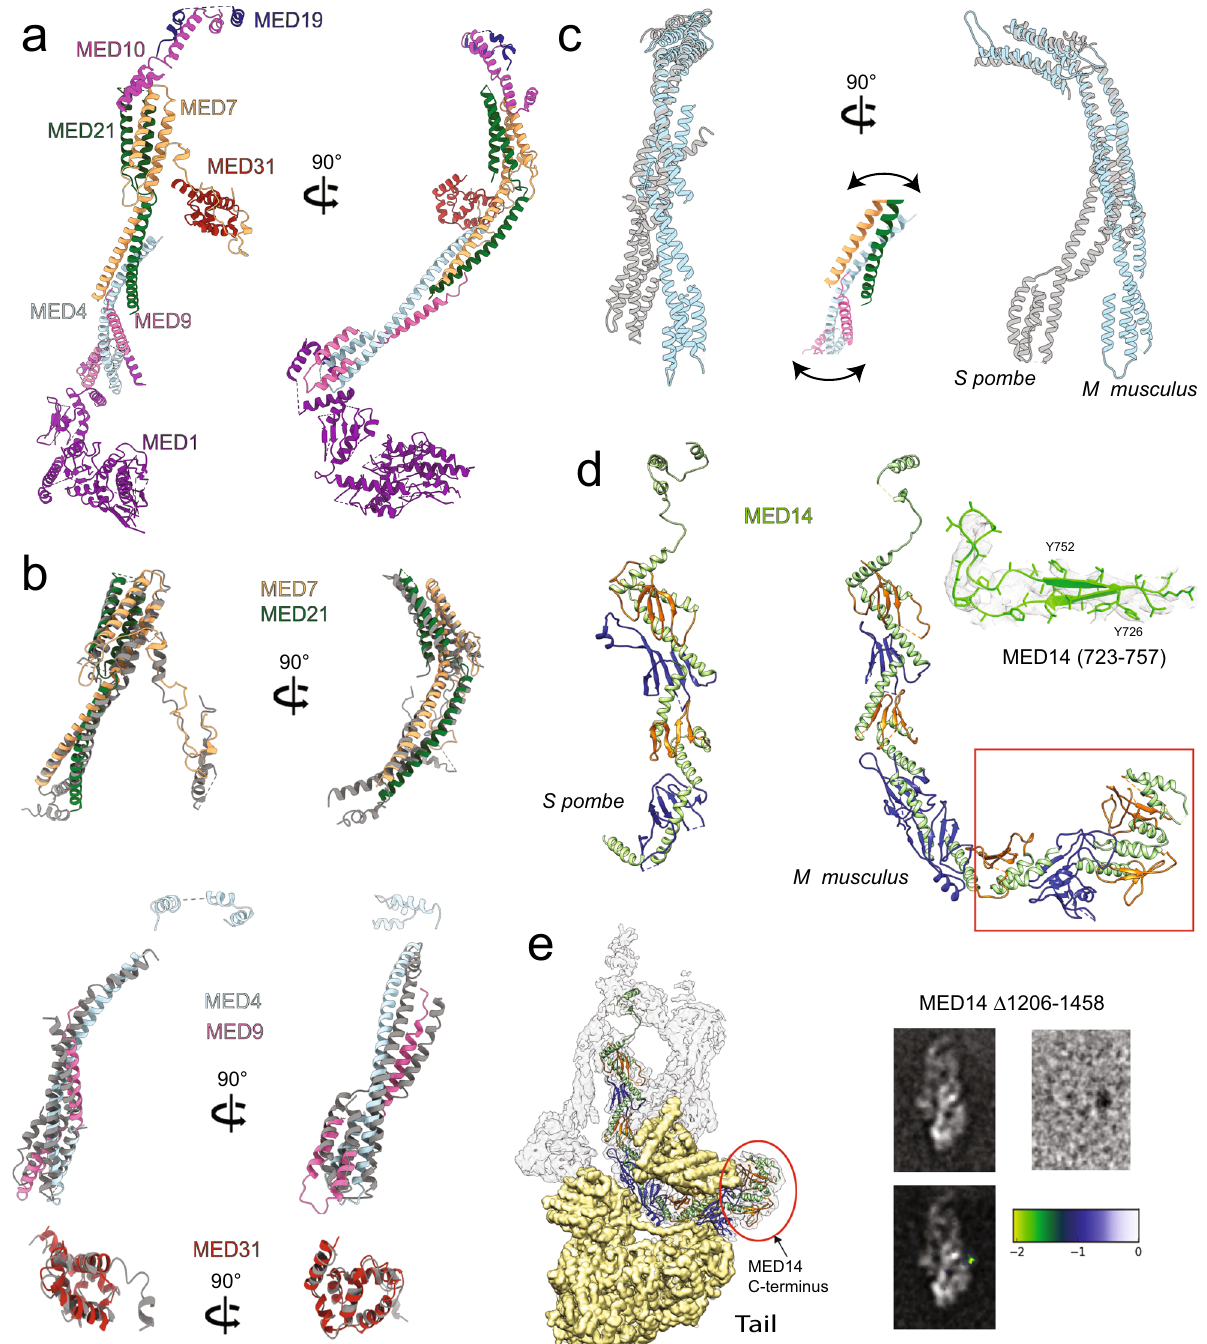
Fig. 3 Structure of the mammalian Middle module and MED14. a Overall mammalian Middle module structure, including a partial MED1 model. b The structure of MED7 – MED21 (top), MED4 – MED9 (middle) and MED31 (bottom) are mostly conserved between yeast and mammalian Mediators (yeast subunits in gray). c The conformation of the mammalian Middle (light blue) differs considerably from that of the yeast Middle (gray) due to fl exing at the MED7 – MED21/MED4 – MED9 interface (see inset for details). d The structure of mammalian MED14 ’ s N-terminal portion structure is remarkably similar to the corresponding portion of yeast MED14, but the mammalian subunit is considerably larger due to an extended C-terminus (highlighted by red rectangle). Elucidation of the MED14 structure was facilitated by considerable detail in the cryo-EM map (inset). e The mammalian MED14 C-terminus interacts extensively with the Tail module (left). The position of MED14 ’ s extreme C-terminal portion (highlighted by red ellipse on the left) was con fi rmed by difference mapping of a MED14 Δ 1206 – 1458 mMED mutant. A MED14 Δ 1206 – 1458 mMED class average and the difference map obtained after subtracting an aligned mMED class average are shown in the top right. Difference map densities colored by standard deviation (as indicated in the color scale) and superimposed on a mMED class average are shown in the bottom